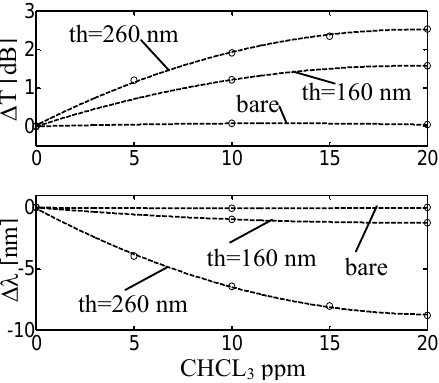
Figure 24. Comparison of the sensitivities, in terms of attenuation band wavelength shift and peak loss reduction, for a bare, a 160 nm coated and a 260 nm coated